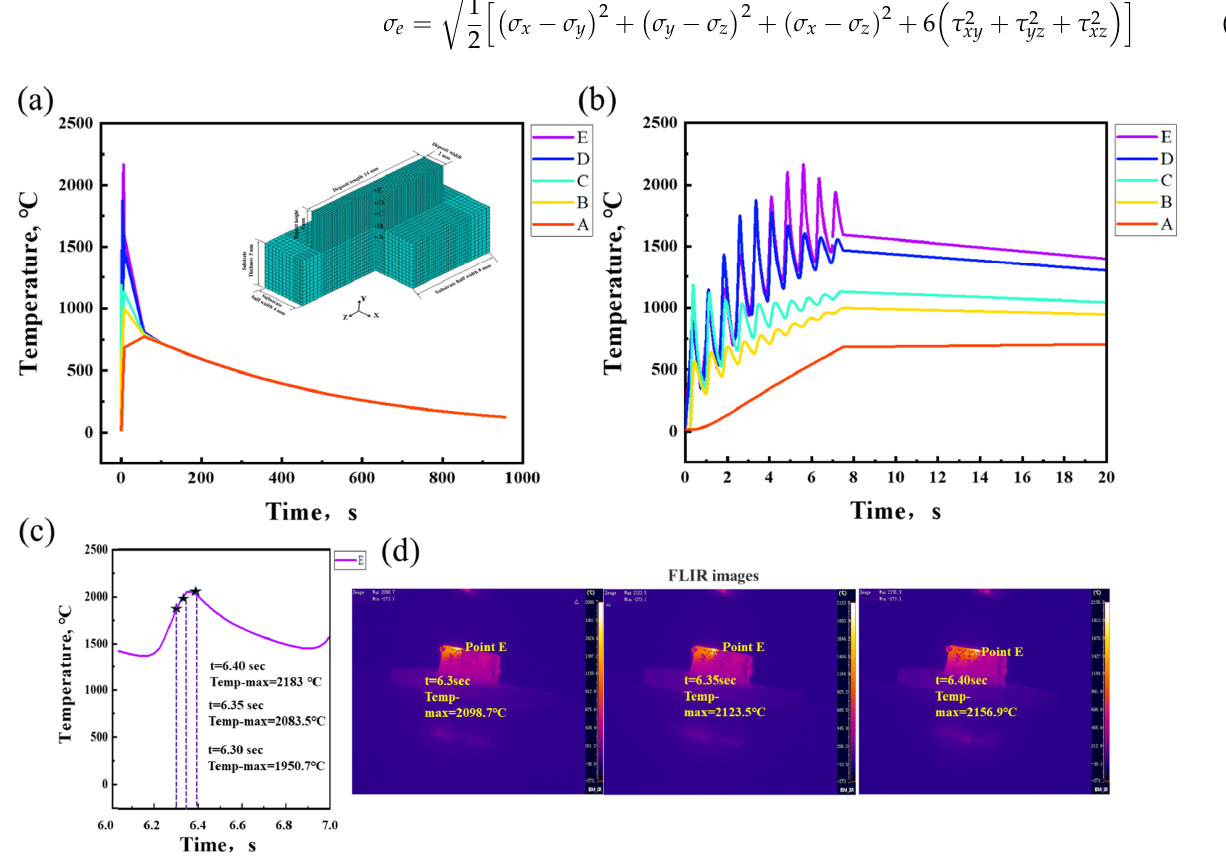
Figure 3. ( a ) Schematic image of selected points in the longitudinal section and temperature curve of different points during the DED process; ( b ) a partial enlargement of ( a ); ( c ) the temperature field and temperature gradient field distribution of point B at t = 6.30 s, t = 6.35 s, and t = 6.40 s, respectively; ( d ) FLIR A615 infrared thermal imager at t = 6.30 s, t = 6.35 s, and t = 6.40 s.